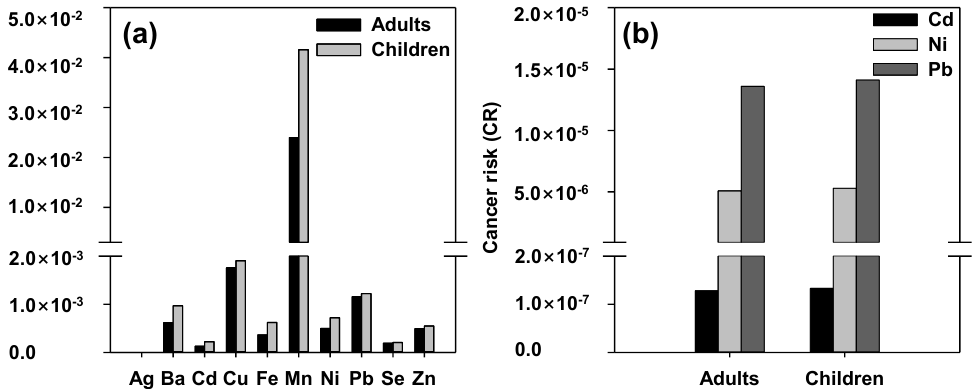
Figure 6. Non-carcinogenic hazard index (HI, ( a )) and cancer risk (CR, ( b )) of adults and children in the Han River watershed.